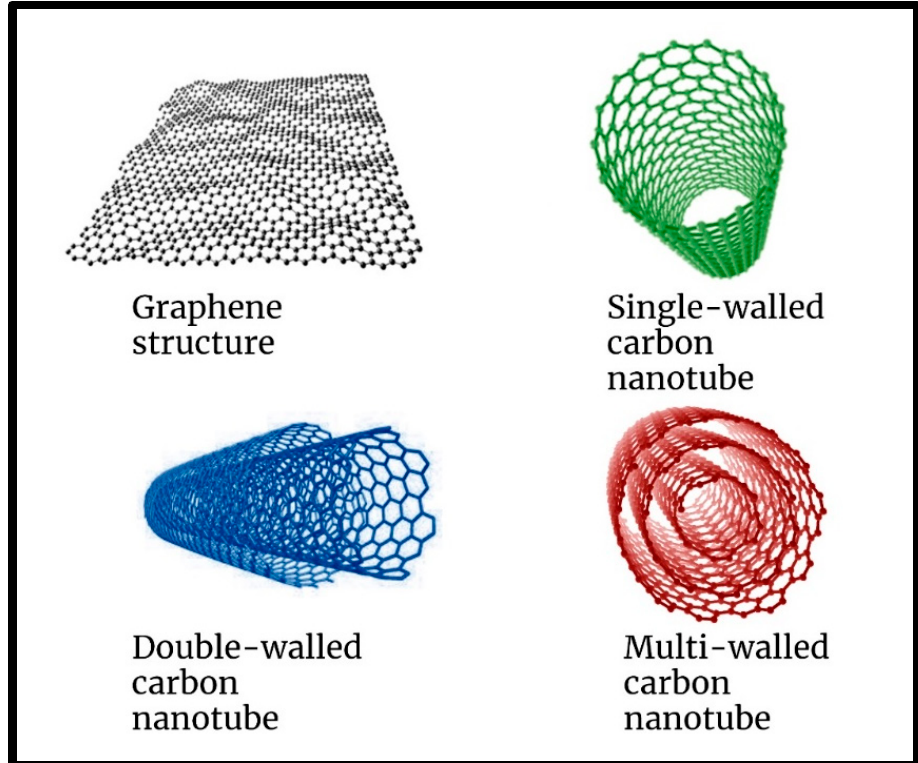
Figure 1. Graphene structure of single, double, and multi-walled carbon